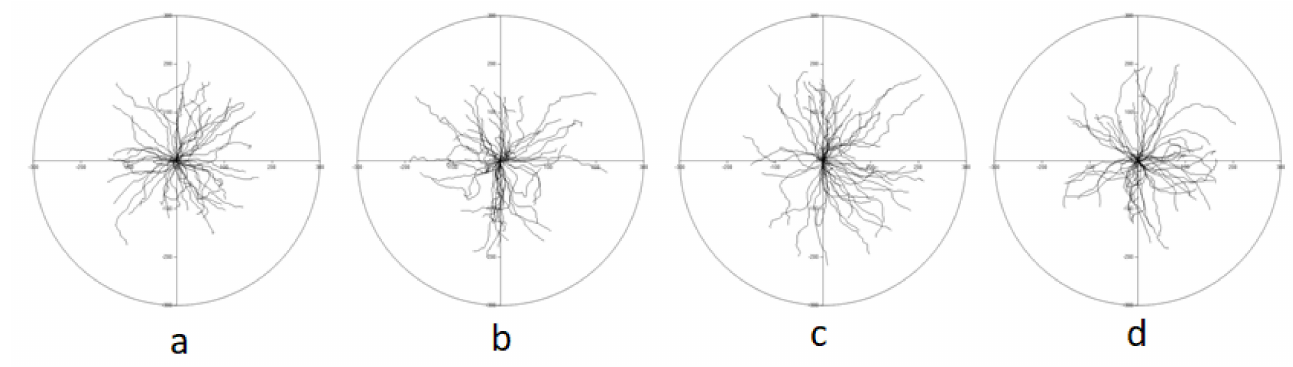
Figure 7. Diagrams representing keratinocyte motility. The starting point of individual cell trajectory is in the center of the diagram; vehicle control ( a ), lupeol acetate ( b ), lupeol isonicotinate ( c ) and lupeol acetylsalicylate ( d ). Cells were seeded 4 days before adding compounds at the density of 5 × 10 4 cells per well of a 6-well plate. Cell traffic was recorded for 1.5 h, 90-sec step in time, starting 30 min after the addition of tested compounds (100 µ M). Average values from each of 3 patients are presented (50 keratinocytes per patient). Table 1. Movement parameters of cells; time-lapse monitoring of individual cell motility (2: lupeol acetate, 4: lupeol isonicotinate, 6: lupeol acetylsalicylate). Data presented as mean values ±